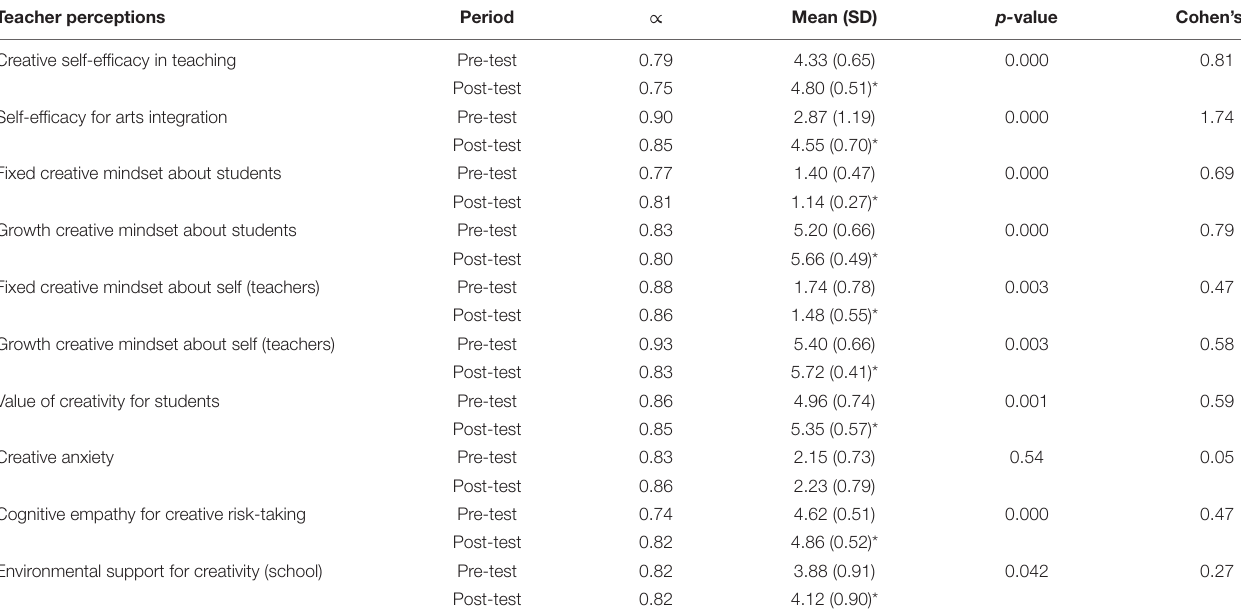
FIGURE 4 | Timeline of participant recruitment, course engagement and completion, and assessments. TABLE 2 | Results of within-teacher ANOVA for perceptions, beliefs, and affect related to creative agency in teaching. Teacher